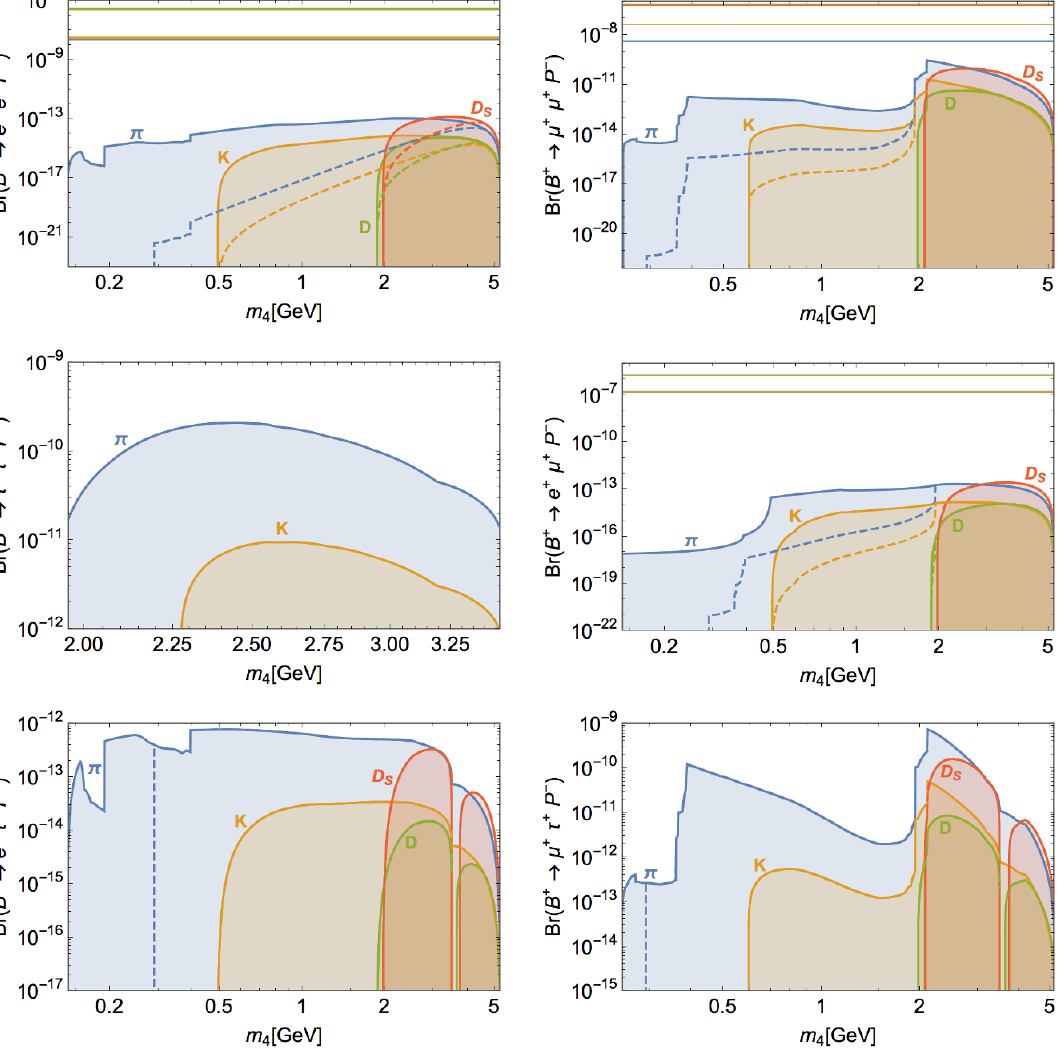
Figure 8 . Branching ratios of LNV decay modes of B + mesons (into pseudoscalar (cid:12)nal states, plus leptons of same or di(cid:11)erent (cid:13)avour), as a function of the (mostly sterile) heavy neutrino mass, m 4 . Pale blue, yellow, red and green curves (surfaces) respectively denote the maximal (allowed) values of the BR( B + ! ‘ (cid:11) ‘ (cid:12) P (cid:0) ), with P (cid:0) = (cid:25) (cid:0) , K (cid:0) , D (cid:0) and D (cid:0) ; coloured dashed curves denote the s corresponding maximal values of the BRs once c(cid:28) 4 (cid:20) 10 m is imposed. The coloured horizontal lines correspond to the present experimental bounds, when available (cf. table 2). From top to bottom, left to right, the (cid:12)nal state lepton content is e + e + , (cid:22) + (cid:22) + , (cid:28) + (cid:28) + , e + (cid:22) + , e + (cid:28) + and (cid:22) + (cid:28) + .